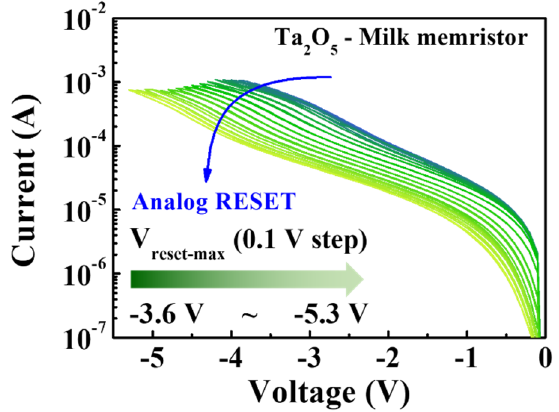
Figure 4. Analog RESET process of milk − Ta 2 O 5 hybrid crossbar array memristors.